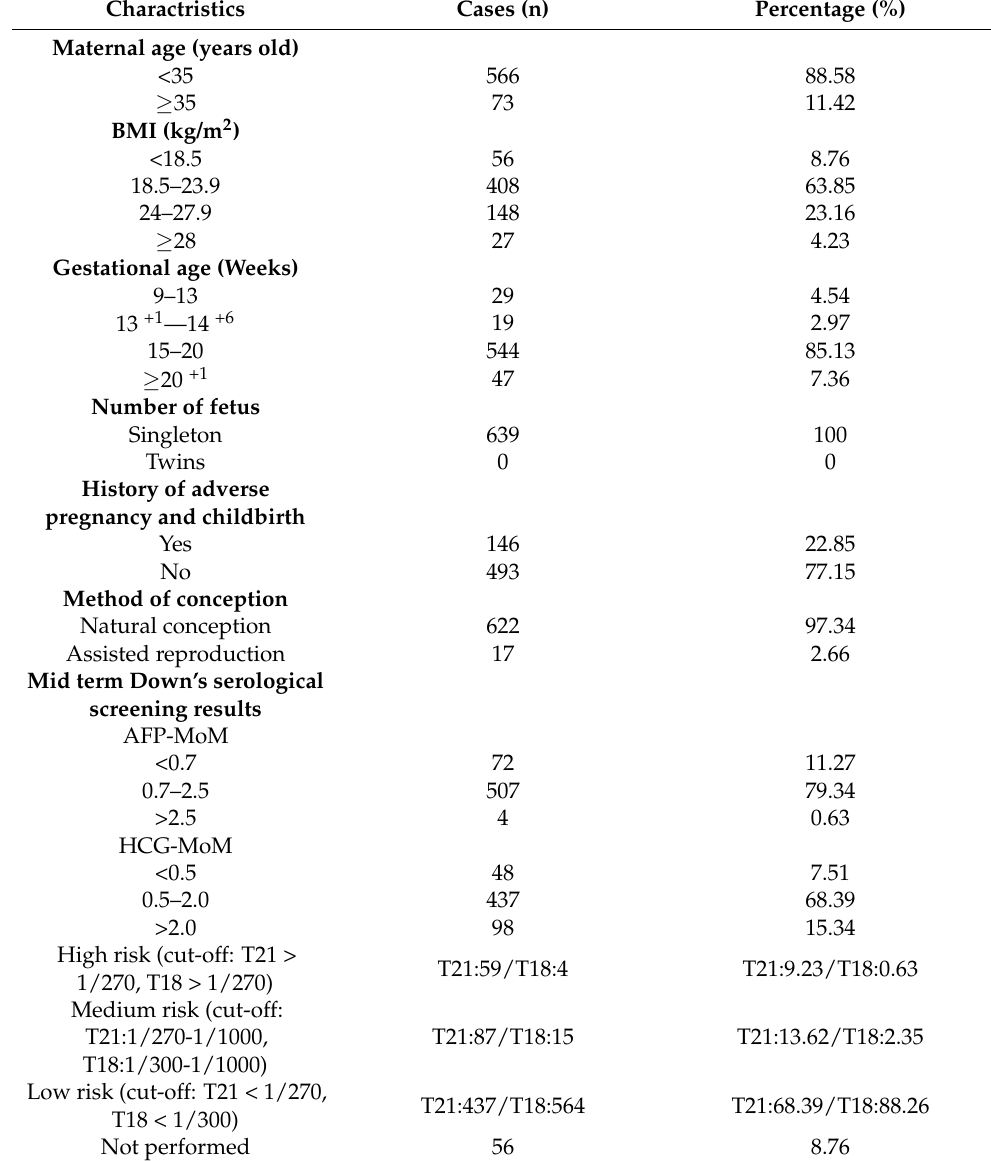
Table 1. The basic clinical characteristics of pregnant women with 639 cases sex chromosome abnormalities for